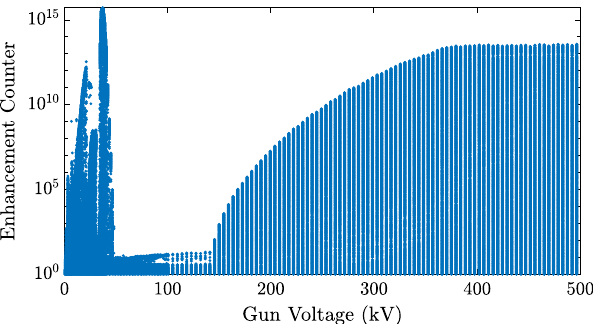
FIG. 9. Enhancement counter as a function of accelerating voltage in the SRF gun simulated by